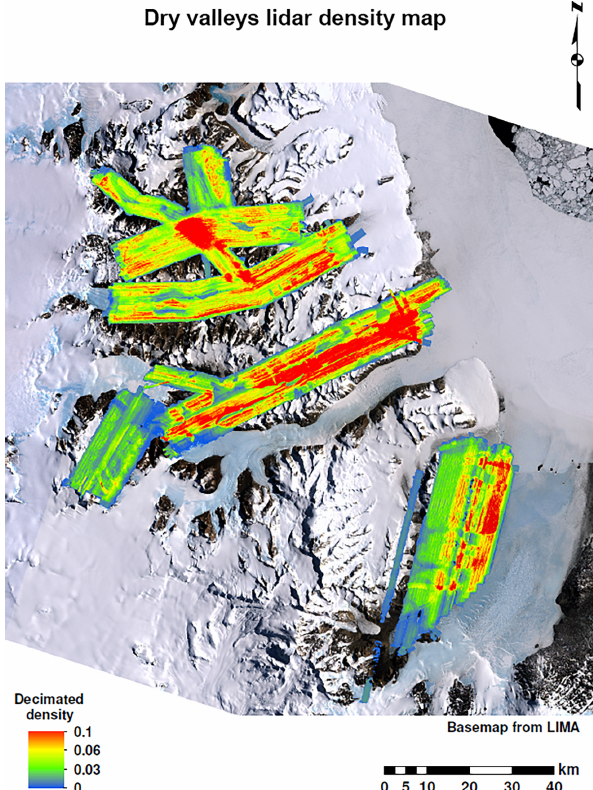
Figure 5. Return density map for the 2013–2014 lidar survey of the McMurdo Dry Valleys. The units of density are returns m − 2 × 10. Base map is the Landsat Image Mosaic of Antarctica (Bindschadler et al.,